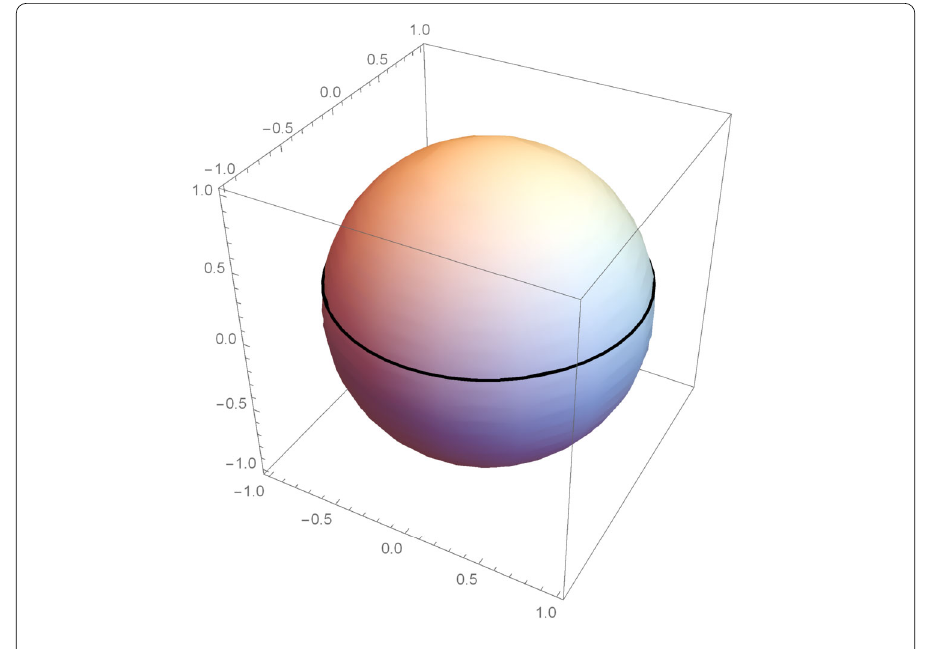
Figure 3 μ 1 -indicatrix of γ